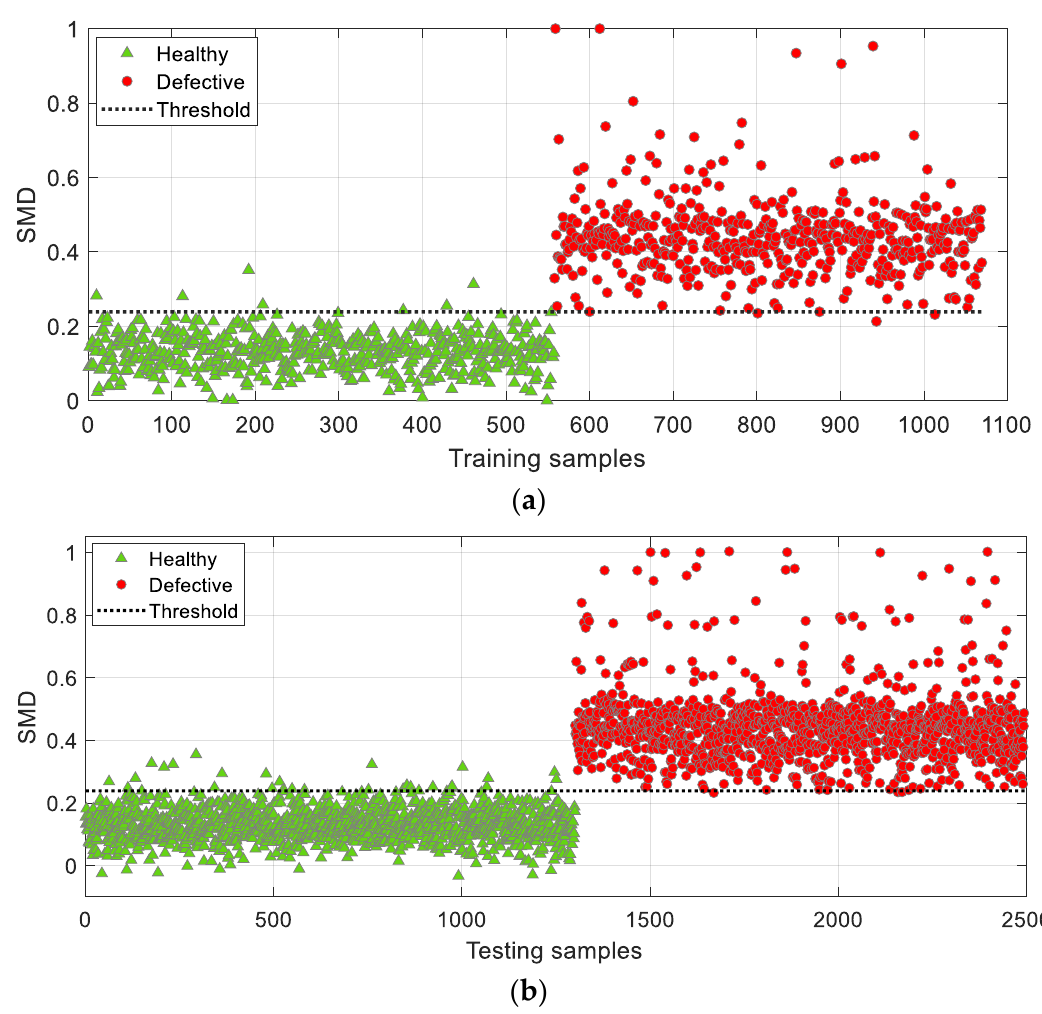
Figure 11. ( a ) Classification on the training dataset; ( b ) classification on the testing dataset.